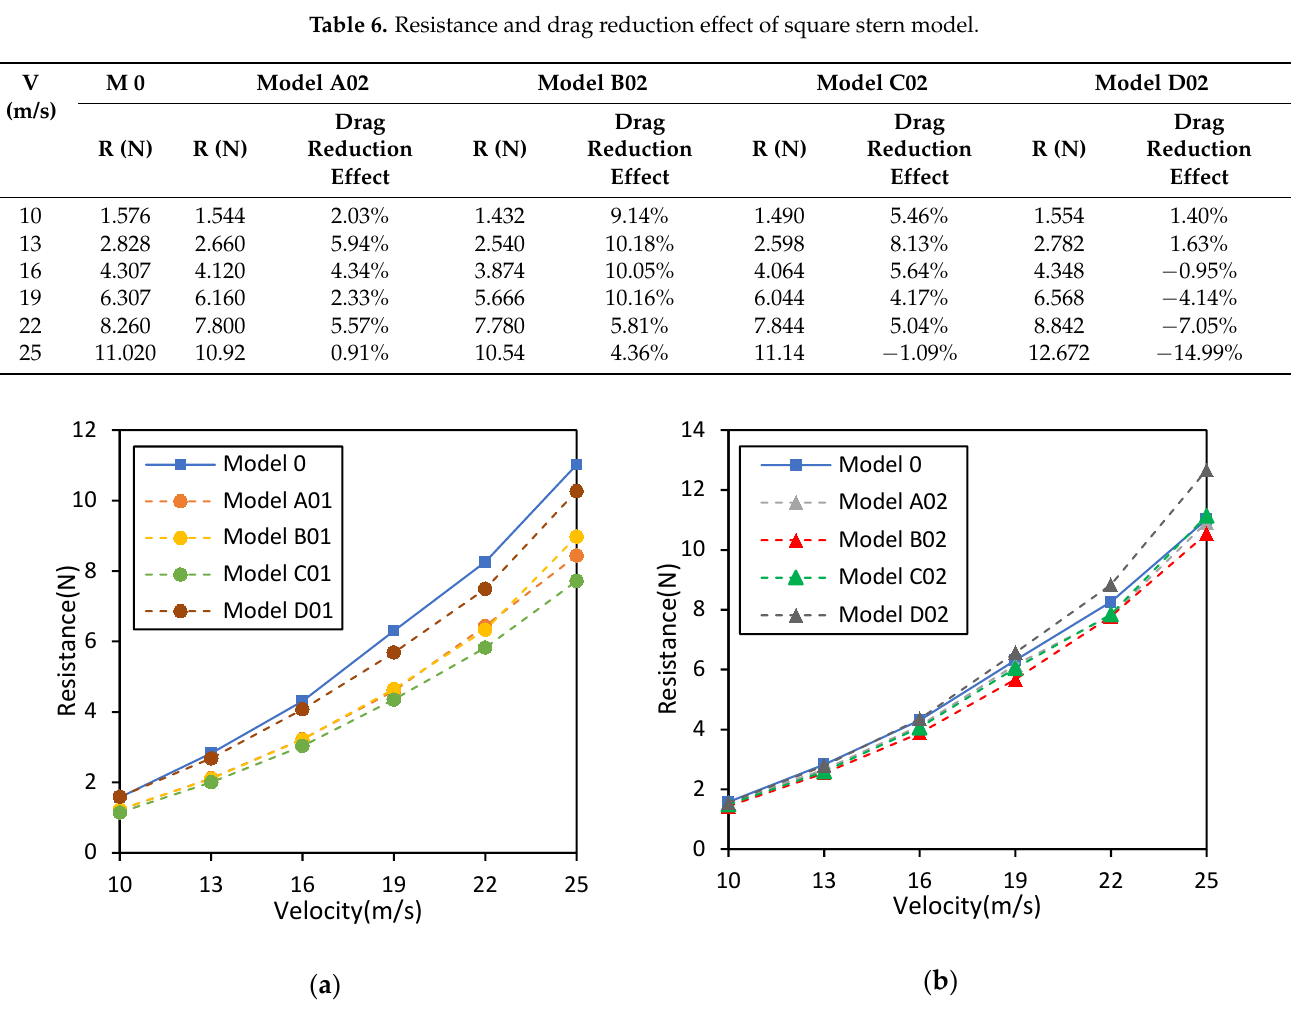
Figure 13. The resistance line charts of each model: ( a ) Resistance line chart of arc stern model under various speed conditions; ( b ) Resistance line chart of square stern model under various speed conditions.